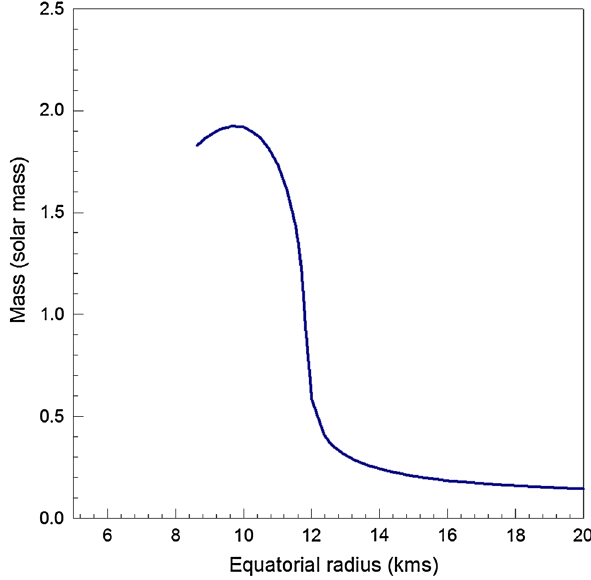
Fig. 2 Mass–equatorial radius plot of slowly rotating neutron stars for the DDM3Y